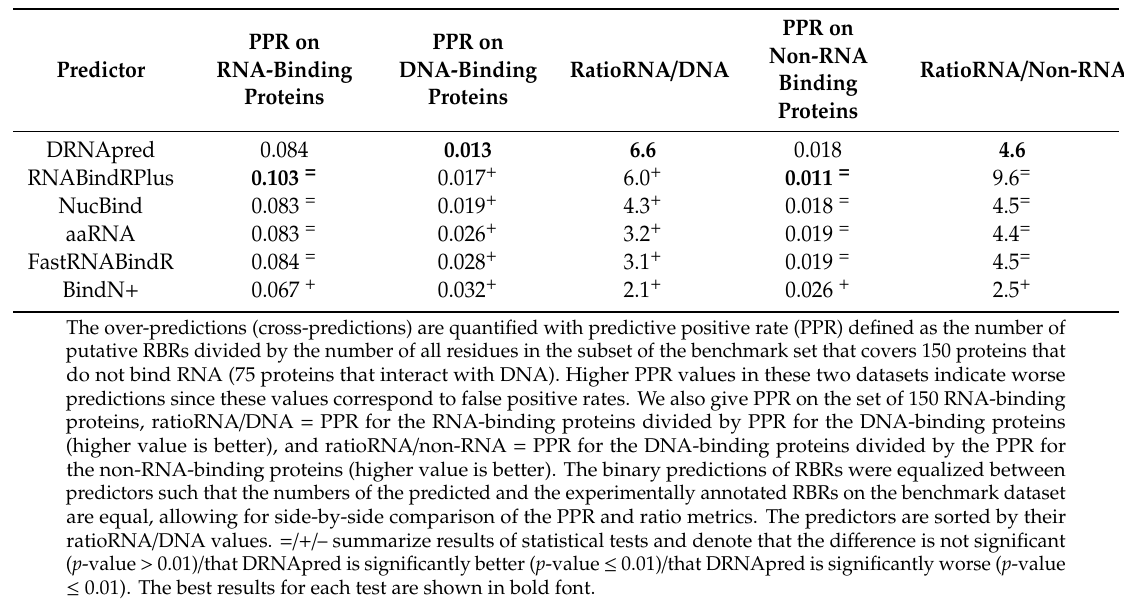
Table 4. Assessment of the over-predictions and cross-predictions for the six partner-agnostic sequence-based predictors of RBRs on the benchmark